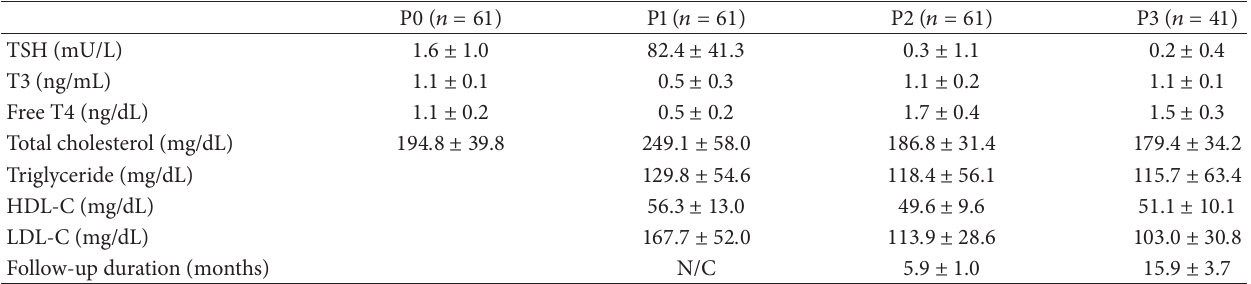
Table 2: Serial changes of thyroid function test results and lipid profiles after thyroid hormone withdrawal.